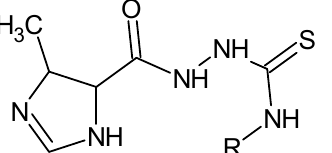
Figure 18. The structure of 1-(4-methylimidazol-5-oyl)-4-substituted thiosemicarbazide. The 1-methyl-4-nitroimidazole-2-carbohydrazide was a starting material for the syn- thesis of new thiosemicarbazide derivatives (Figure 19). All compounds were screened for their antiparasitic activity. Most of the compounds tested showed very good nematicidal activity. Selected compounds may become potential candidates for anthelmintic drugs. The uents were more active than albendazole [86].